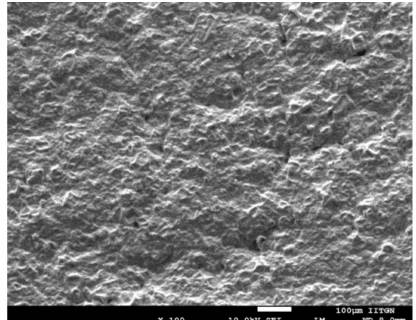
Figure 4. Representative scanning electron microscopy image of drug in adhesive pioglitazone (6% w / w ) patch with propylene glycol.